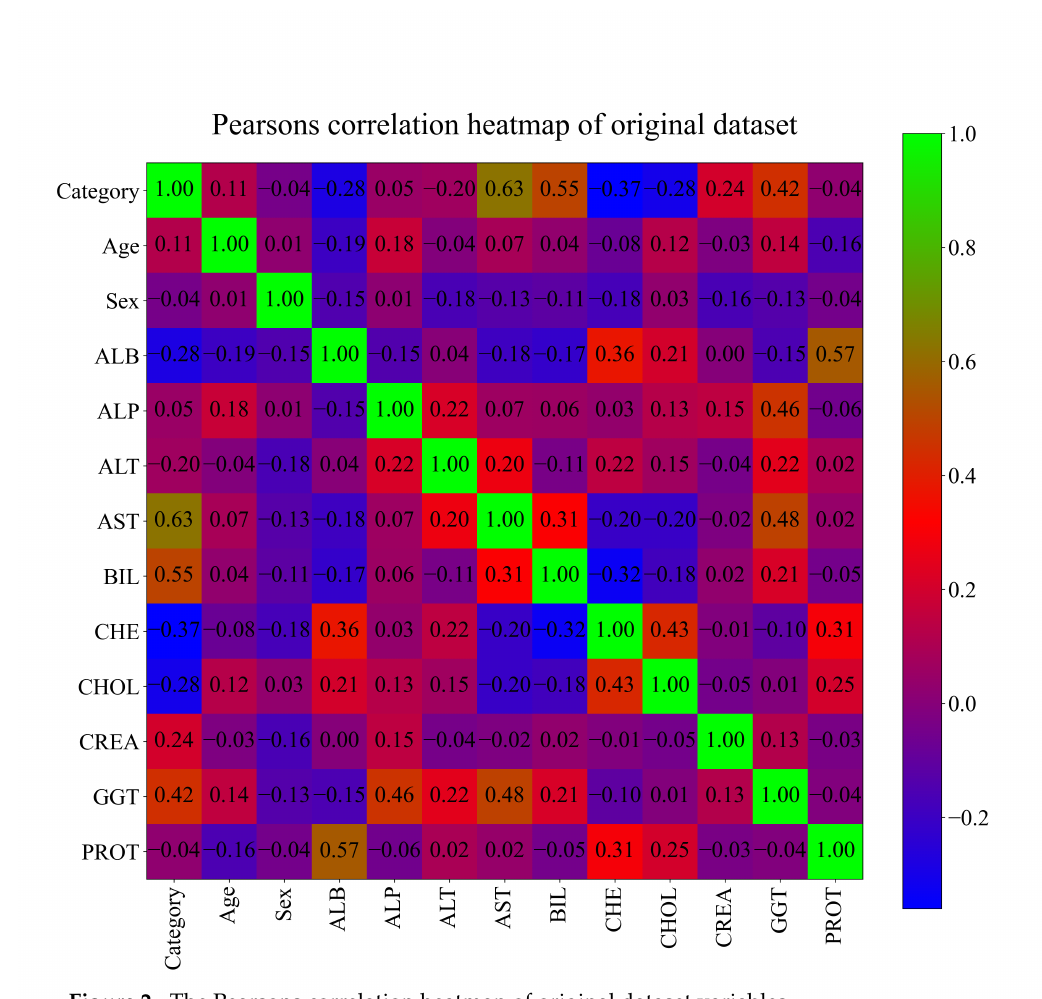
Figure 2. The Pearsons correlation heatmap of original dataset